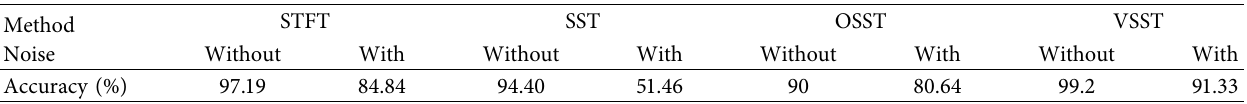
Figure 12: Flowchart of bearing fault diagnosis based on gray level cooccurrence matrix (GLCM) from grayed TFRs. Table 2: Comparison of accuracy of state